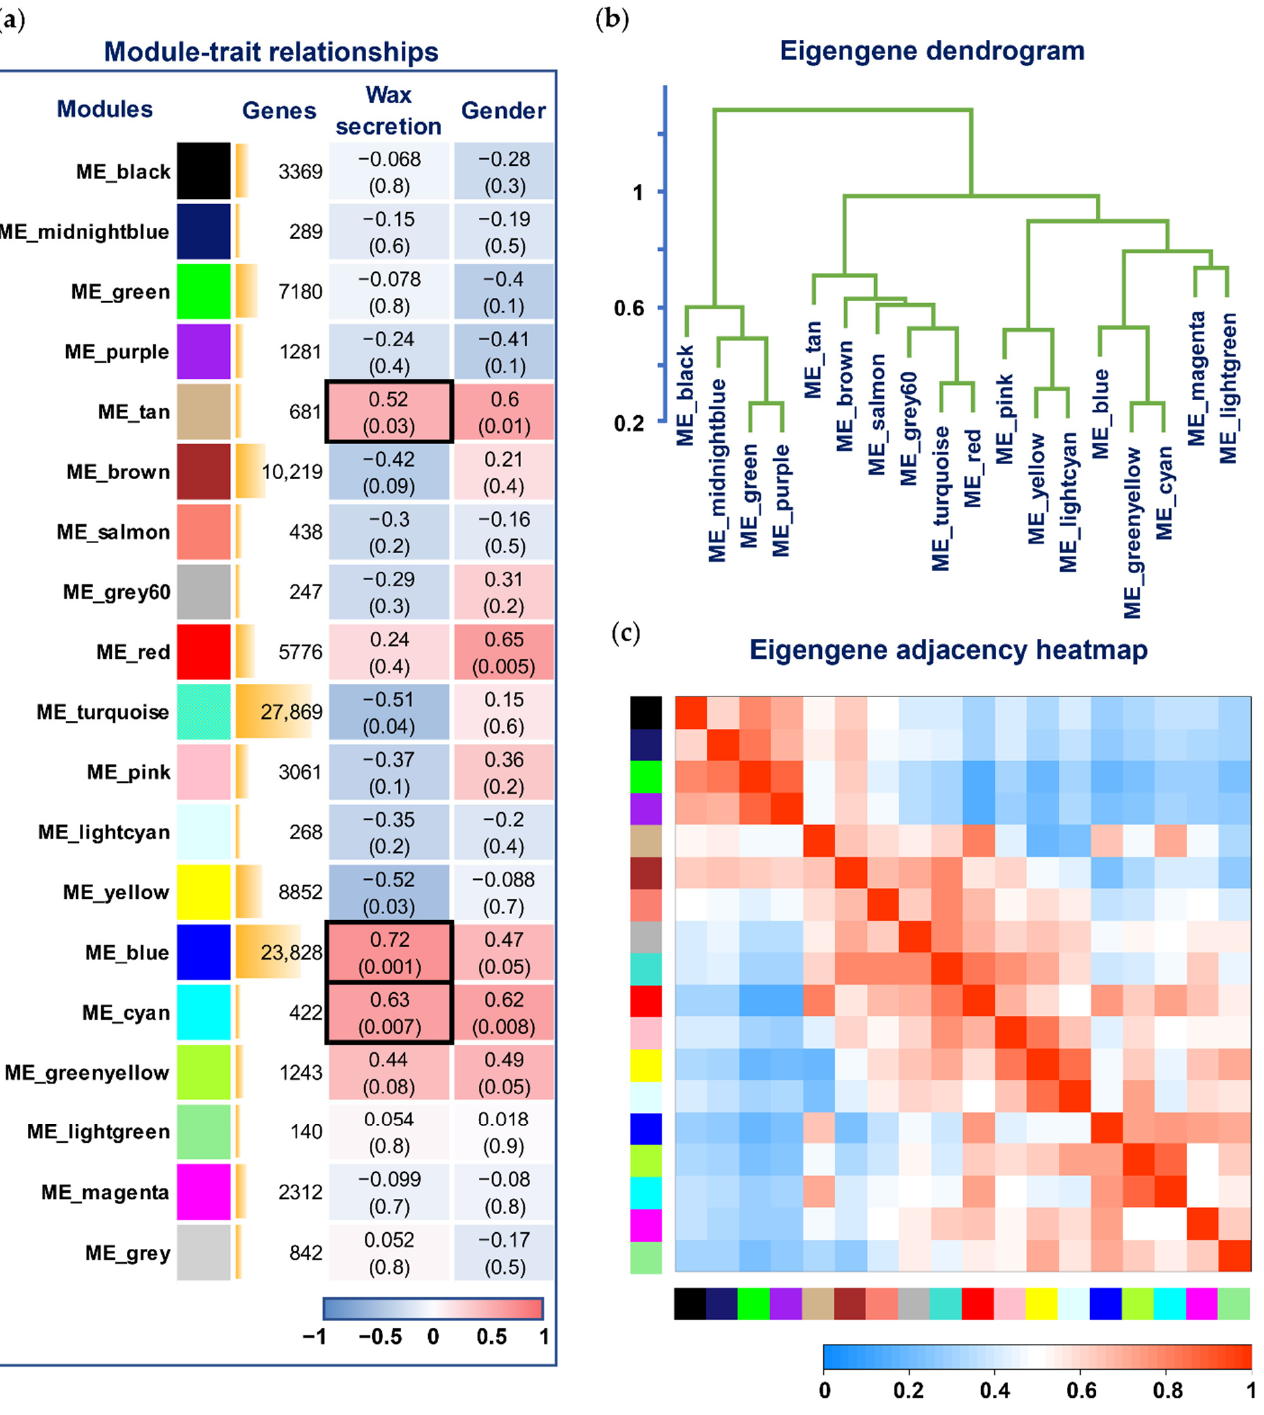
Figure 2. Visualization of the relationship between modules and wax secretion traits. ( a ) Module–trait associations. Each row corresponds to a module eigengene, each column corresponds to a trait, and each cell contains the corresponding correlation and p -value. The table is color-coded by correlation according to the color legend. The blue, cyan, and tan modules marked with black boxes have the highest association ( p < 0.05) with wax secretion. ( b ) Hierarchical clustering dendrogram of the eigengenes in which the dissimilarity of eigengenes E I and E J is given by 1 − cor(E I , E J ) . ( c ) The heatmap shows the eigengene adjacency A IJ = (1 + cor(E I , E J ))/2. At the same time, we also wanted to know the relationship between the modules.